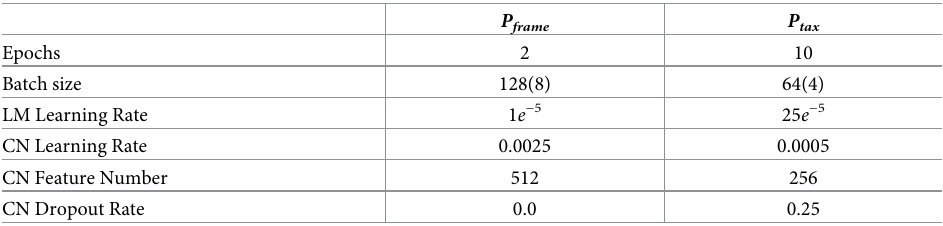
and P frame tax